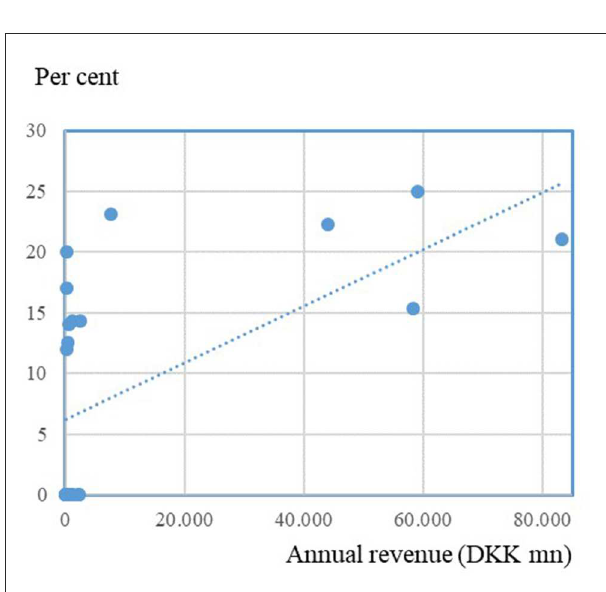
presentation based on annual reports and homepages of 25 farmer-owned cooperatives in Denmark.